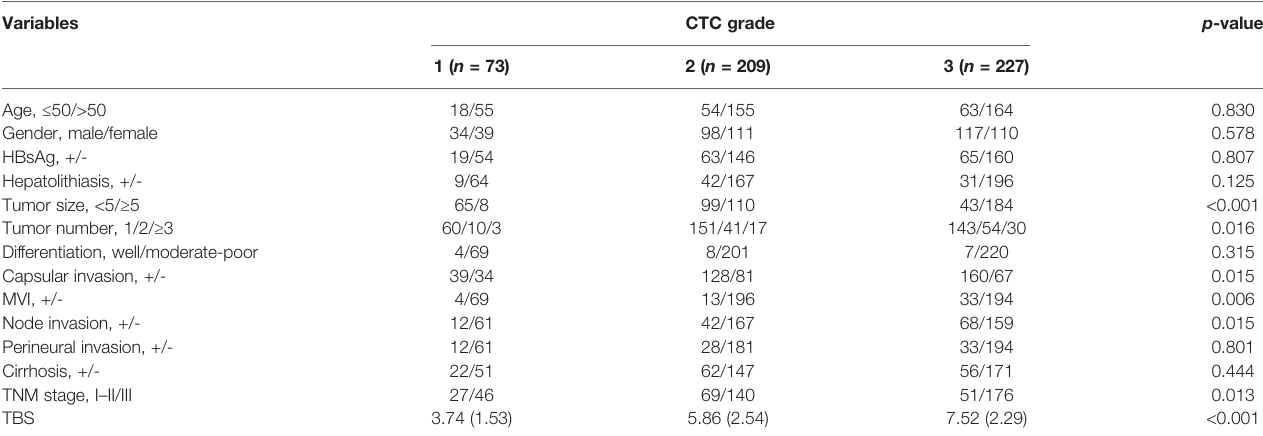
TABLE 2 | Correlation between CTC grade and clinicopathological characteristics in derivation cohort. Variables